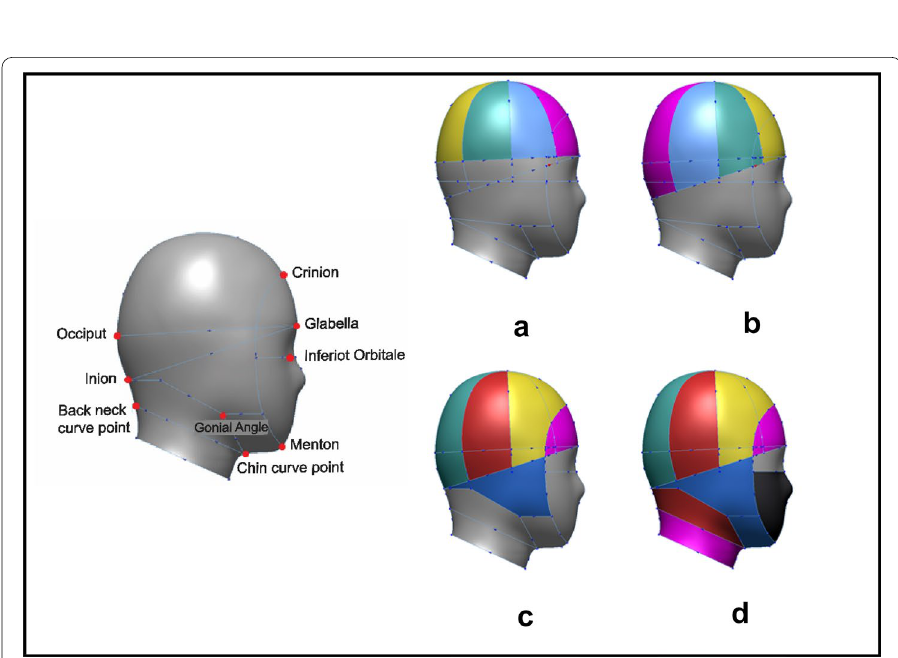
Fig. 3 Results of design baseline creation by hat type. a Crown type; b hood type; c helmet type; d pullover